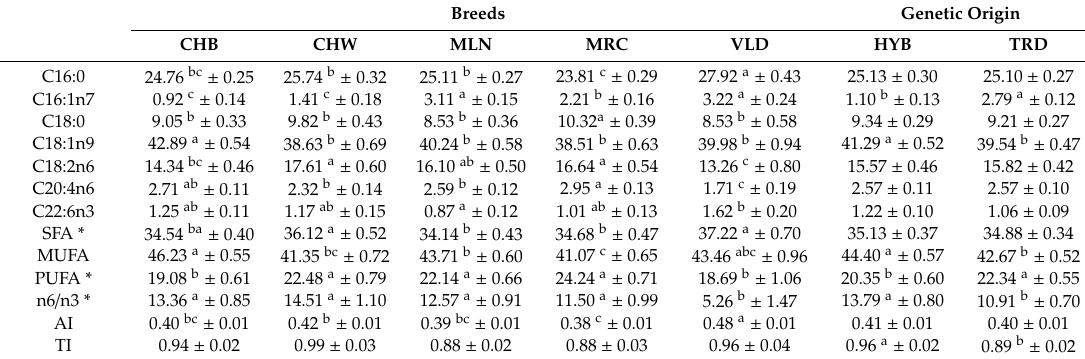
Table 3. Yolk fatty acids composition (%; LS mean ± SE) by breed.